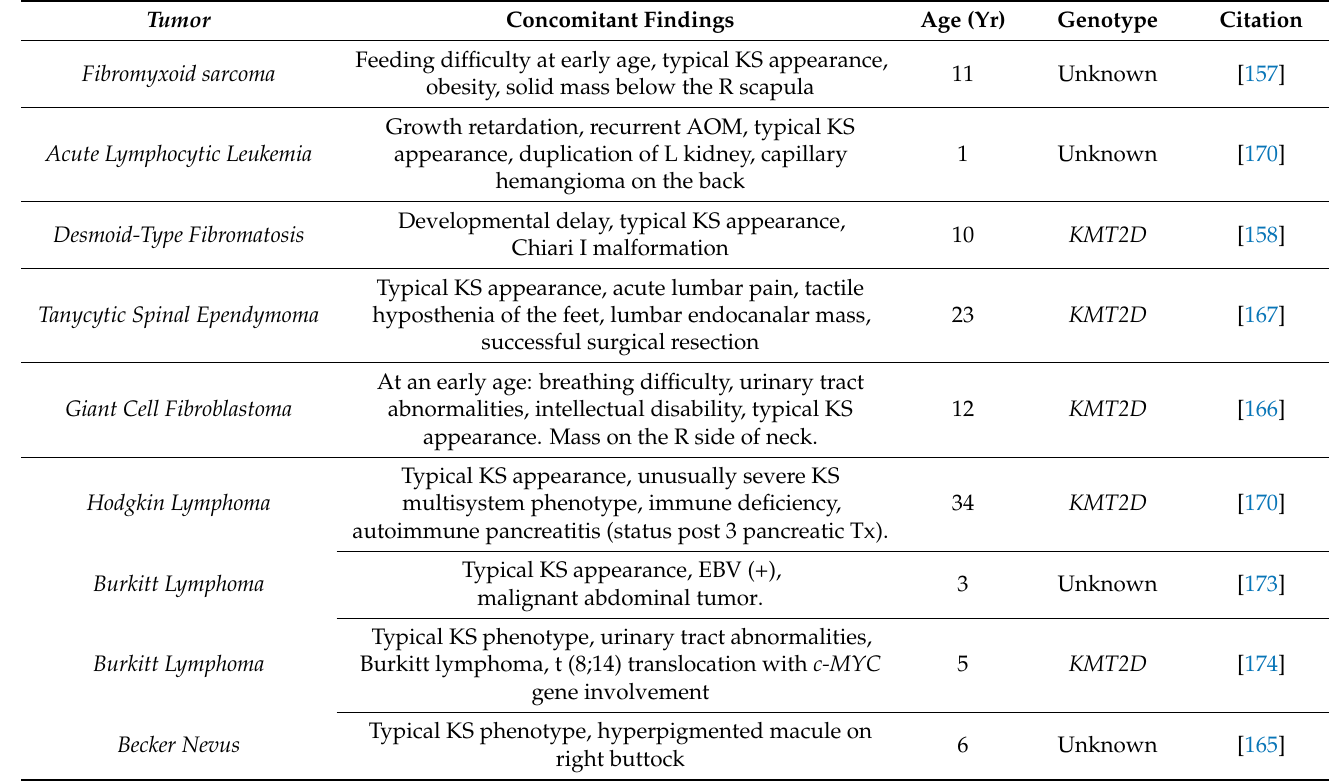
Table 4. Rarely reported tumors in KS patients. AOM—Acute Otitis Media; KS—Kabuki syndrome; L—left; R—right; Tx—transplant; EBV—Ebstein–Barr